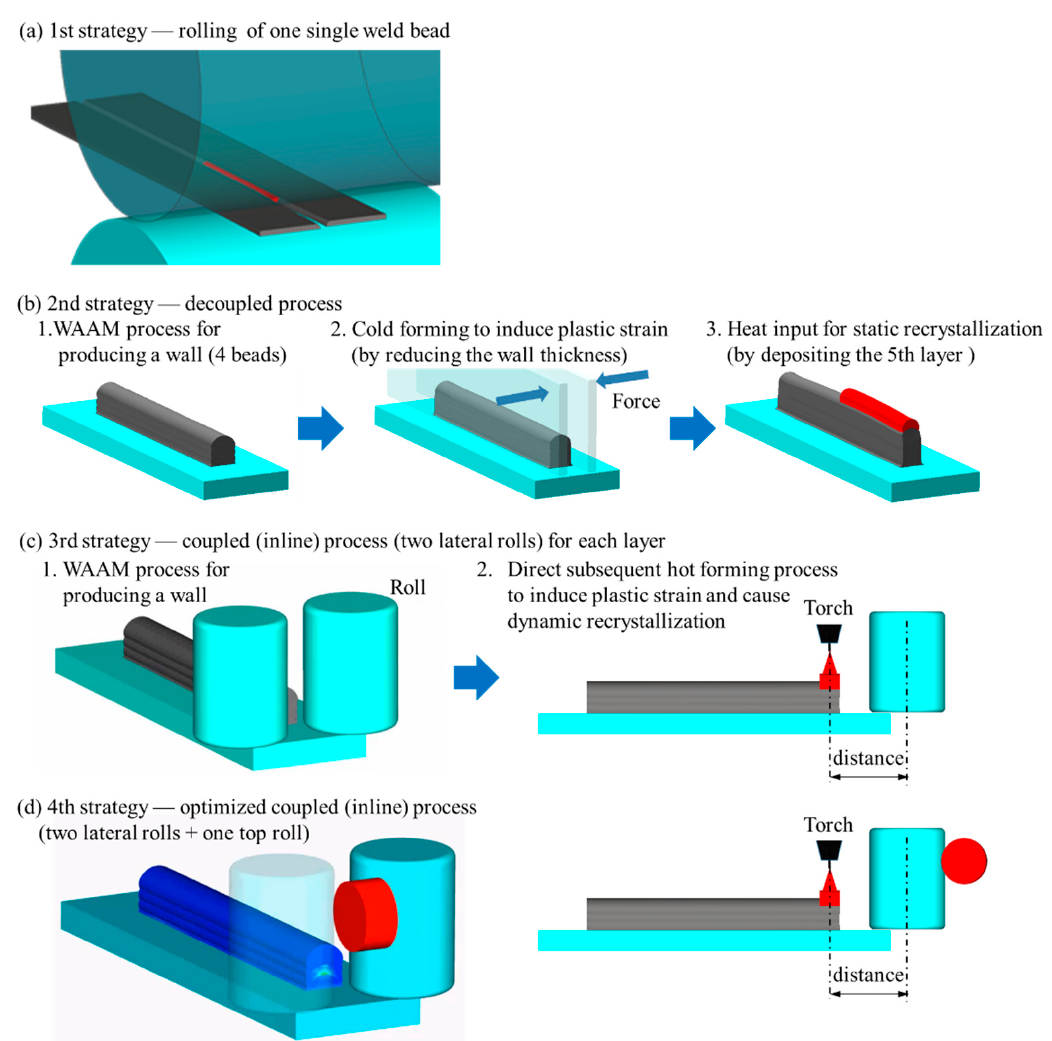
Figure 2. Considered process combinations, ( a ) 1st strategy—process with hot rolling for development and validation of a simulation model with experimental data (Reprinted from Ref. [8]), ( b ) 2nd strategy—decoupled process with cold forming of 4 welded layers and welding one more bead, ( c ) 3rd strategy—coupled (inline) process for 5 layers with welding one bead and a direct subsequent rolling step using two lateral rolls, and ( d ) 4th strategy—coupled (inline) process for 5 layers with welding one bead and a direct subsequent rolling step using two lateral rolls + one top roll.